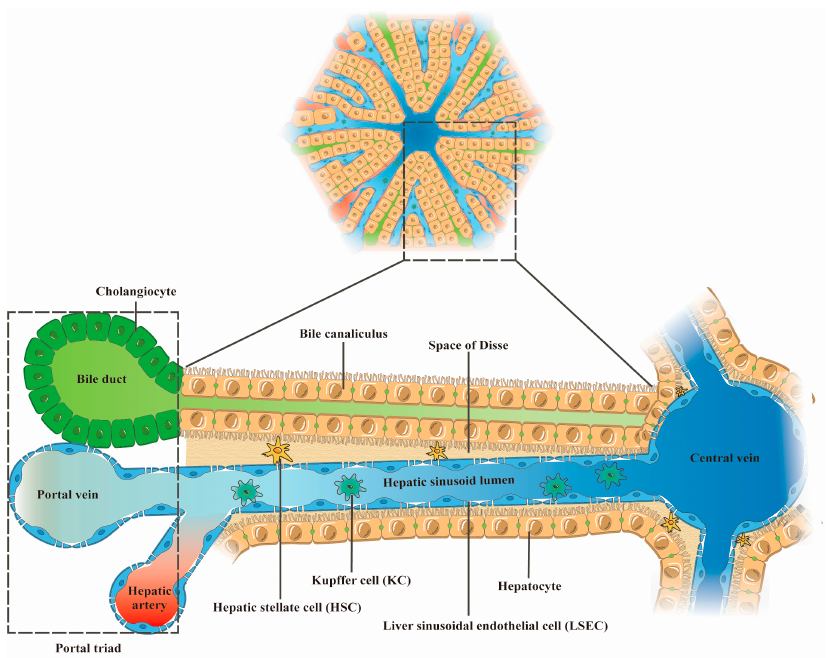
Figure 1. Schematic diagram of liver lobule structure. Table 1. Structure and function of the major liver cell types.